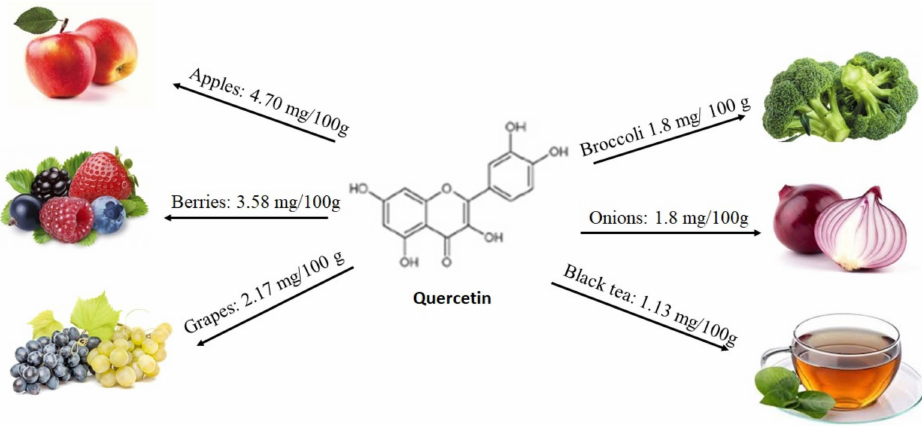
Figure 3. Foods that contains quercetin, according to the database Phenol-Explore (http: // phenol- explorer.eu /